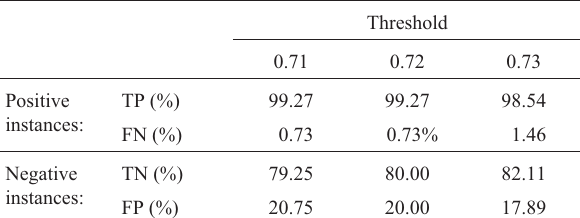
Table 6 - Performance evaluation for model 1.